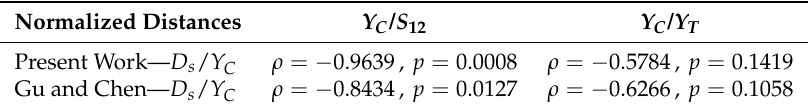
Table 11. Spearman’s Rank-Order Correlation computed between the normalized polyline distances D s / Y C and the ratios Y C / S 12 and Y C / Y T